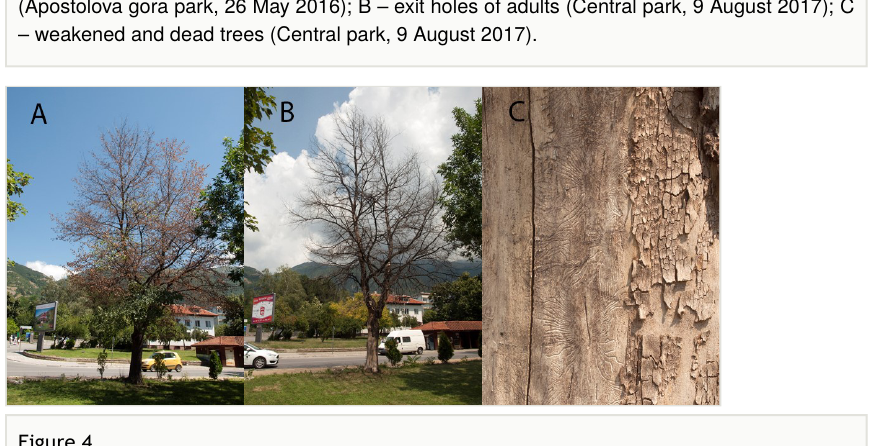
Damage on Ulmus minor caused by Ophiostoma novo-ulmi in Central park: A – dying tree (8 July 2016); B – dead tree (9 August 2017); C – galleries of elm bark beetle, Scolytus multistriatus (9 August